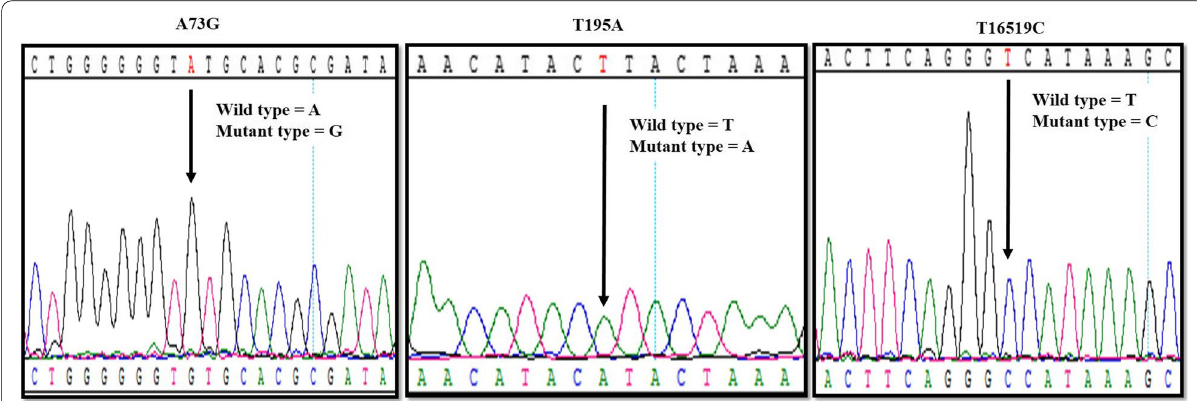
Fig. 2 Chromatogram showing a synonymous mutation in D-loop region of salivary gland tumor at 73, 195, and 16519 base